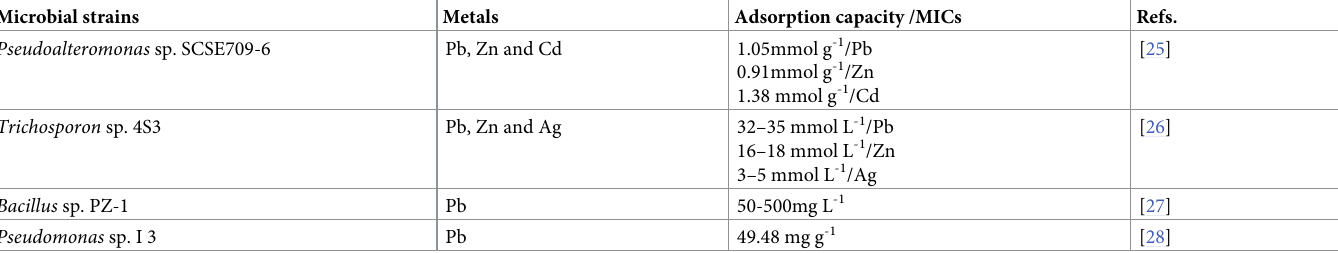
Table 1. Examples of results from the literature on biosorption capacities or Minimal inhibitory concentrations (MICs) for Pb(II), Zn(II) and other heavy metals against various microbial strains. Microbial strains